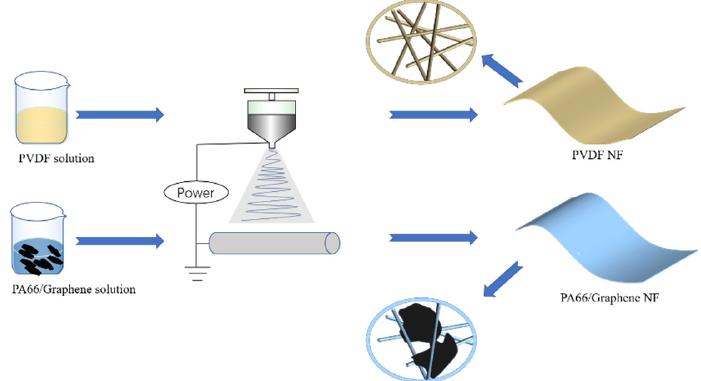
Figure 1. Schematic diagram of electrospinning film.